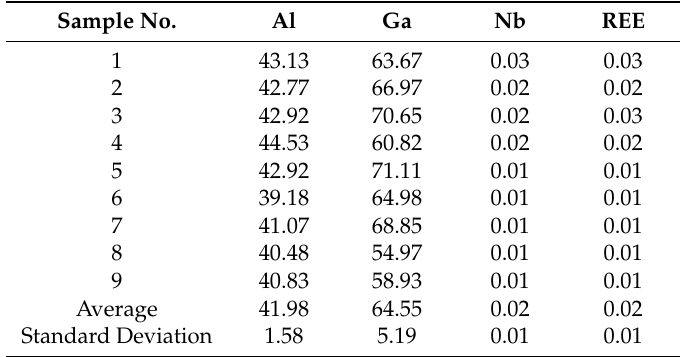
Table 2. Water immersion extraction efficiency (%) of elements of interest.